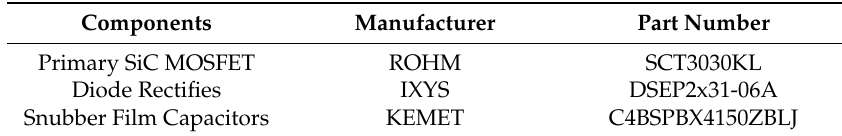
Table 5. Components used in the Figure 21. Laboratory setup of a 3.7 kW WPT system.